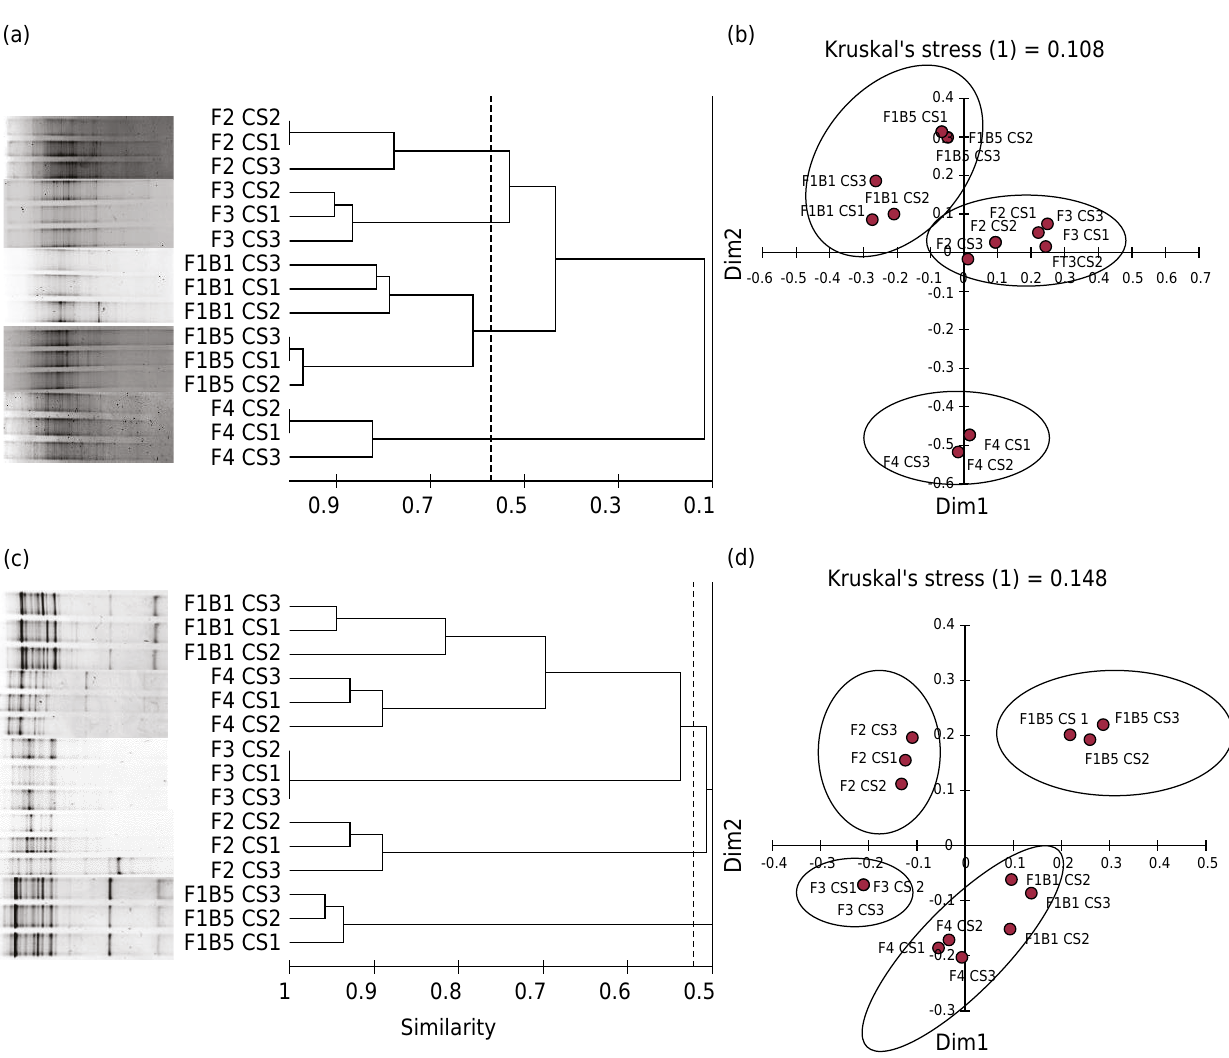
Figure 1. Clustering and MDS ordination data of the 16S rDNA (a and b) and the 18S rDNA (c and d) DGGE banding profiles from soil samples under ecological (F1B1, F1B5), intermediate (F2, F3), and conventional (F4) land management systems. The three bands in the DGGE image associated with each site are the genetic profiles of the three composite soil samples collected from each sampling site. CS 1: composite sample #1; CS2: composite sample #2; and CS3: composite sample